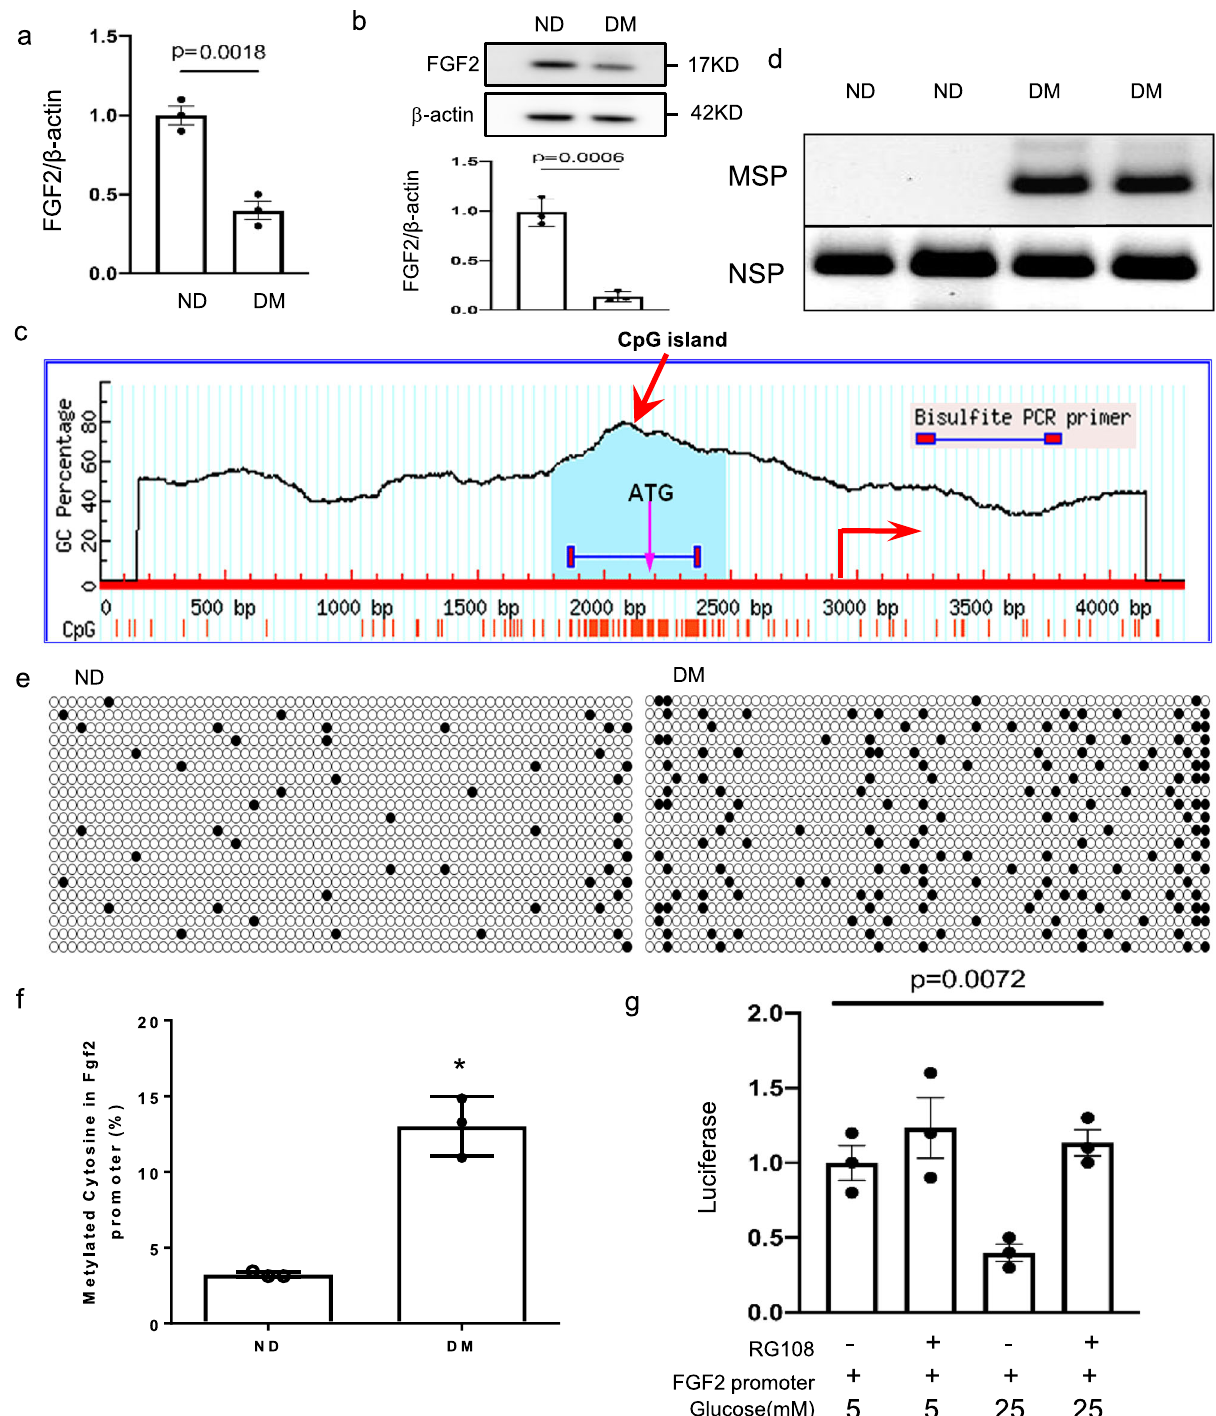
Fig. 1 Maternal diabetes suppresses FGF2 expression through DNA hypermethylation. a , b Abundance of FGF2 mRNA ( a ) and protein ( b ) in E7.5 conceptuses. ( c ) The CpG island (the light green area) of the Fgf2 promoter in E7.5 conceptuses. d The degree of methylation in the CpG island of Fgf2 promoter determined by Methylation-speci fi c PCR (MSP) along with non-methylated speci fi c PCR (NSP). e Methylated C (cytosine) frequencies in the 64 CpG sites of the CpG island after cloning CpG islands from the Fgf2 promoter for bisul fi te sequencing. DNA isolated from E7.5 embryos of three dams ( n = 3) per group and DNA was cloned and sequenced twenty times per group. f Quanti fi cation of methylated cytosine from ( e ). g The methylation inhibitor RG108 restored Fgf2 promoter luciferase reporter activity suppressed by high glucose (25 mM glucose) in the yolk sac endoderm PYS2 cell line. Cells experiments were repeated three times ( n = 3). Experiments were performed using three embryos from three different dam per group ( n = 3). * indicates signi fi cant difference compared to other groups ( P < 0.05). ND: nondiabetic; DM: diabetes mellitus.